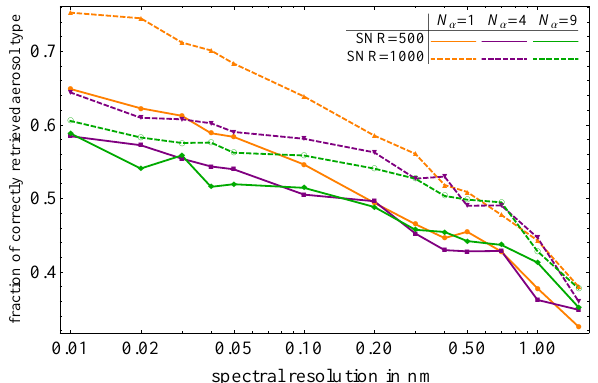
Figure 13. Fraction of correctly retrieved aerosol type with respect to spectral resolution, prescribed signal to noise ratio (solid/dashed lines), and surface inhomogeneity (orange, purple, and green